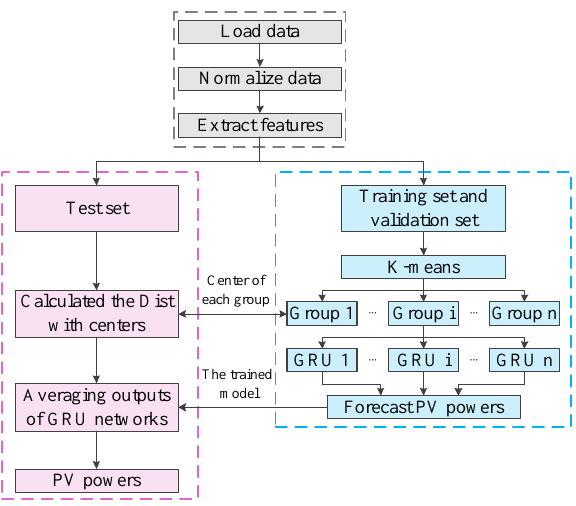
Figure 1. The framework of the proposed approach.